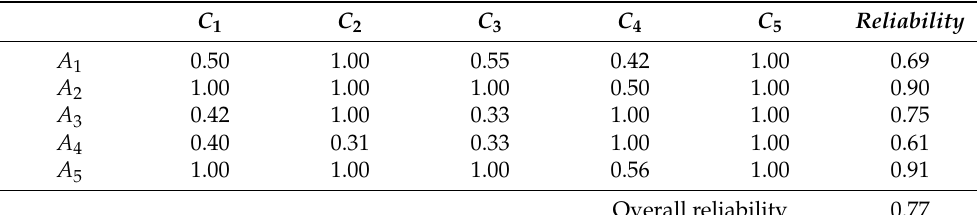
Table 16. The reliability of information obtained from the second of three respondents.